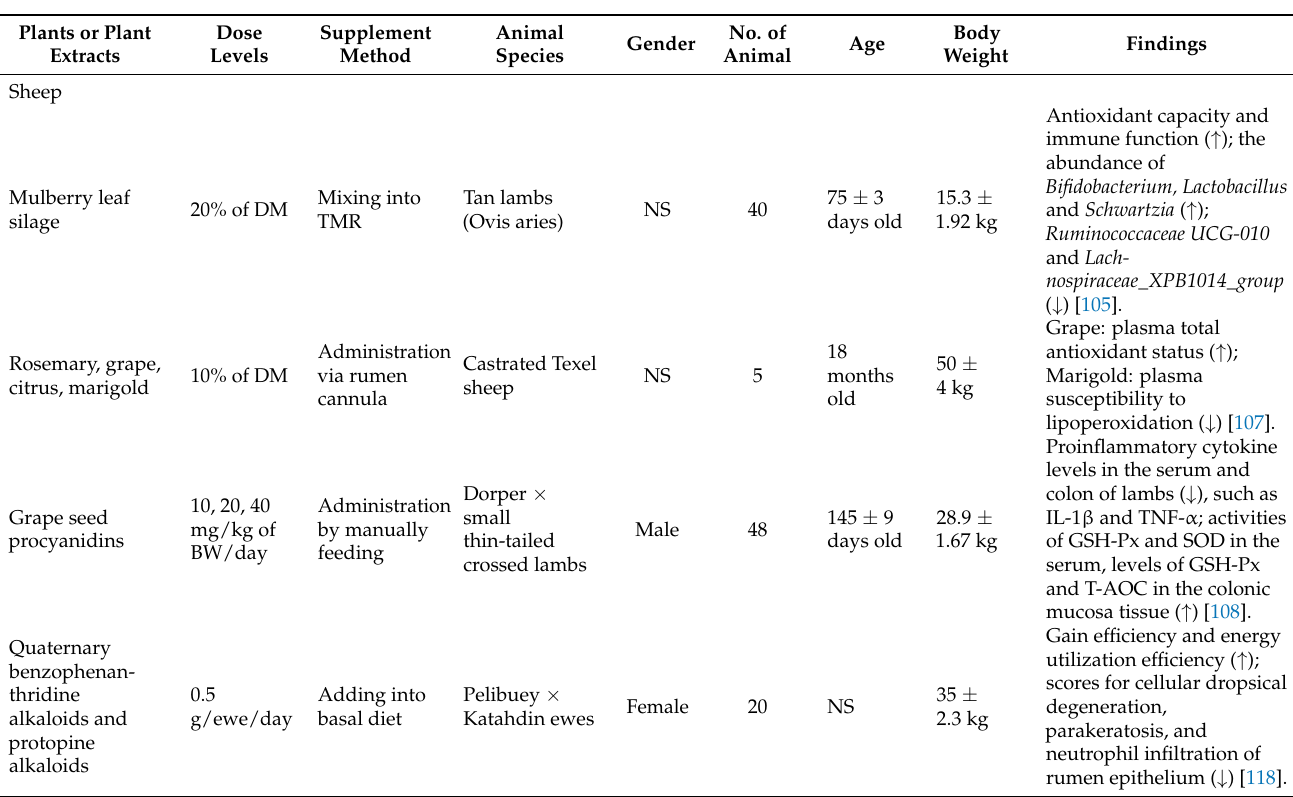
Table 3. Effects of plant extracts on growth performance, feed utilization, and antioxidant capability in sheep and